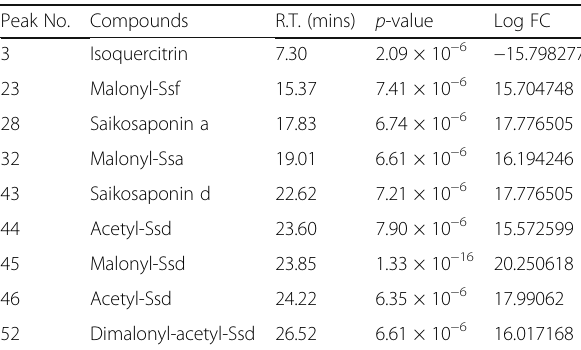
Table 3 List of compounds (9 entities) that are distinguished between root and aerial parts at p < 0.001 and fold change (FC) > 3 Peak No.